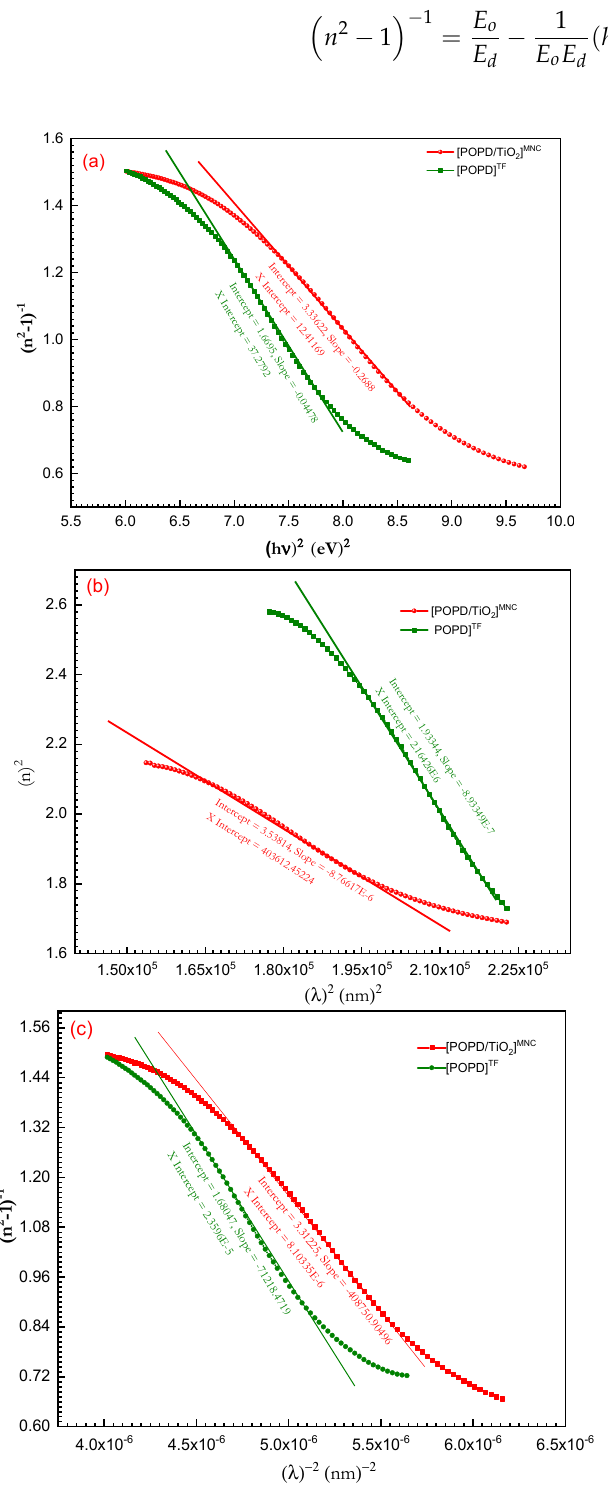
Figure 12. ( a – c ). Application of Wemple–DiDomenico and Sellmeier models on [PoPDA] TF and [PoPDA/TiO 2 ] MNC .